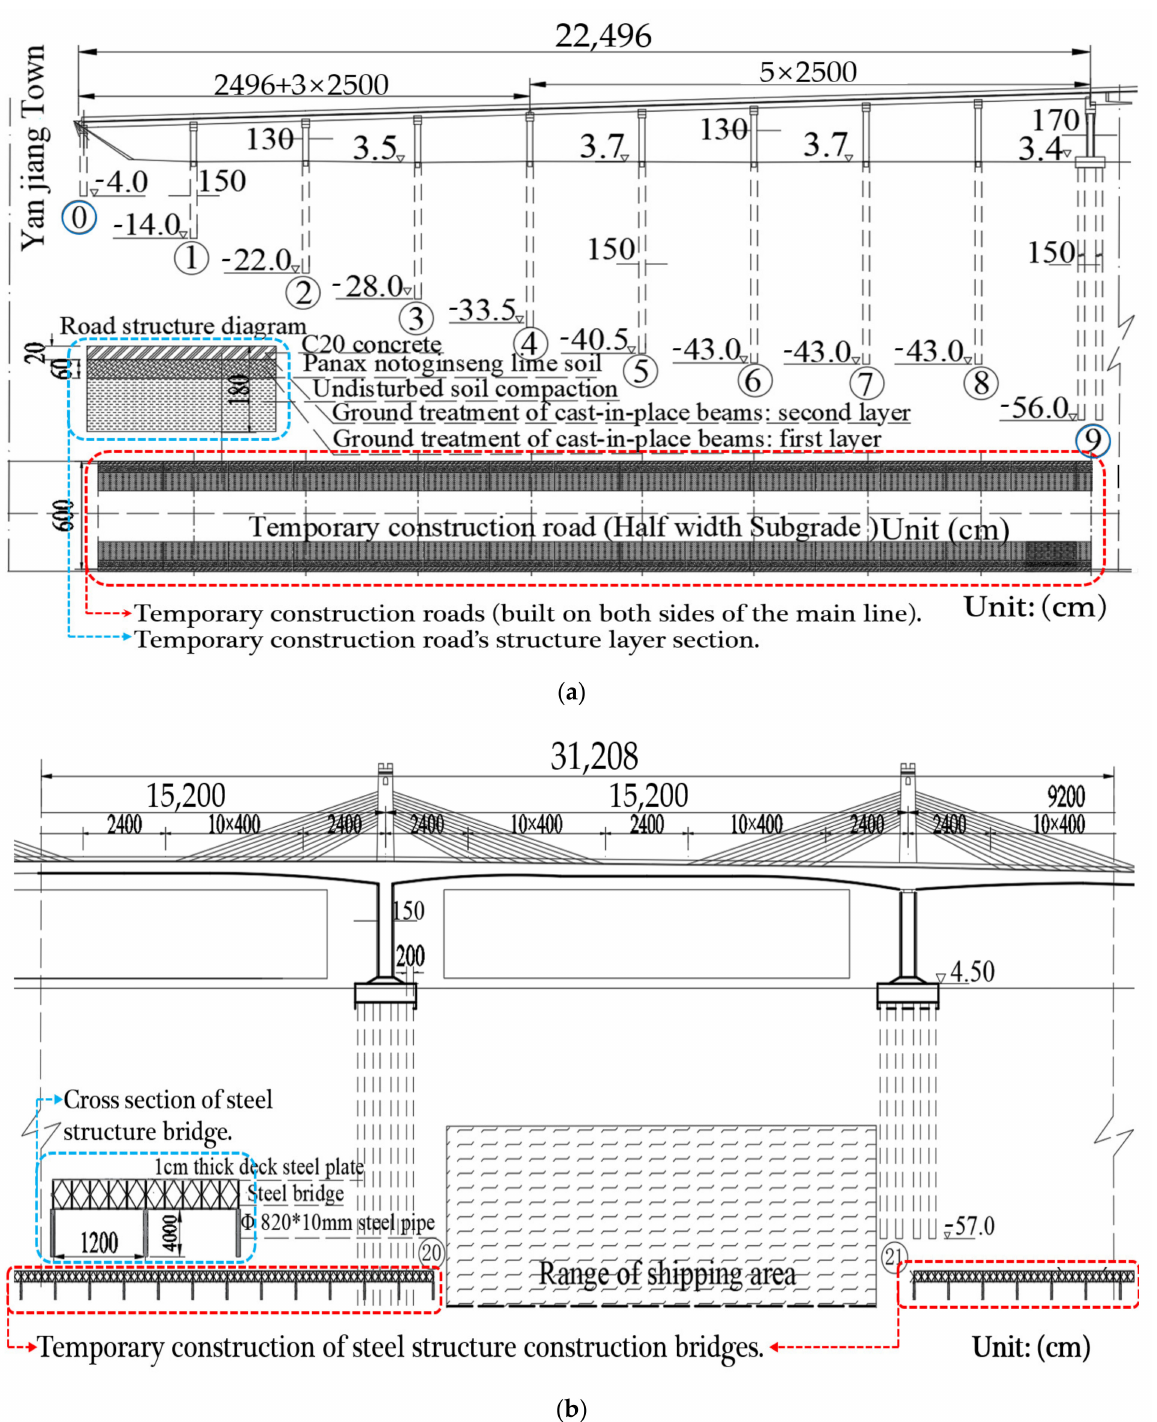
Figure 7. Organization and management plan of construction bridge project: ( a ) Temporary construction of temporary bridge (part); ( b ) Temporary construction of steel structure bridge